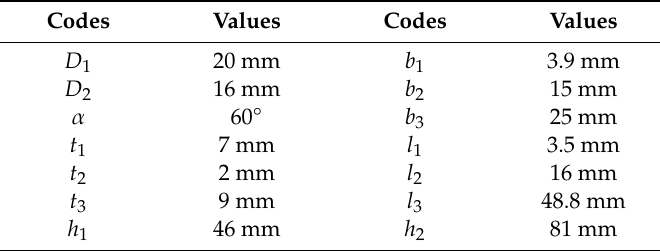
Figure 5. Single blade system. ( a ) Fan blade; ( b ) limit switch. Table 7. Basic design parameters.